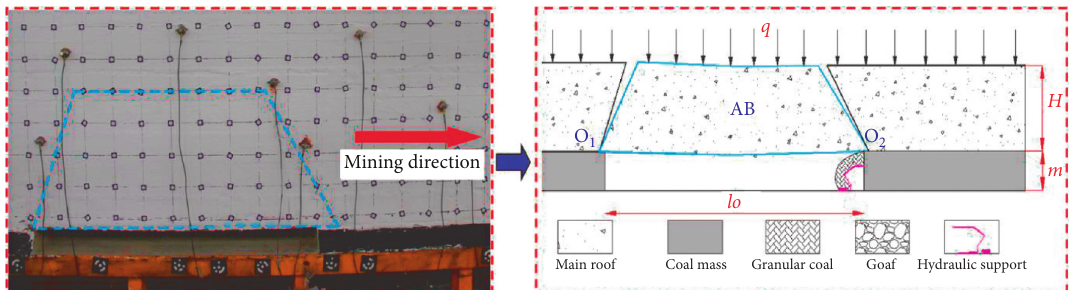
Figure 4: Fracture structure model of the THR first weighting at a close distance.